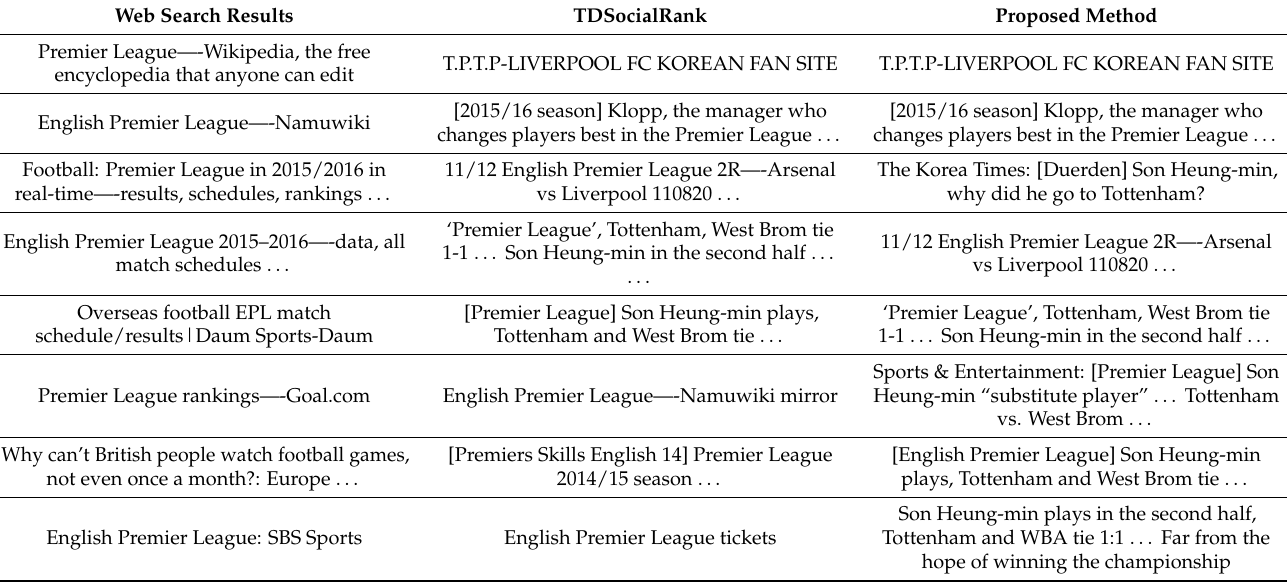
Table 2. Search results for the Premier League.